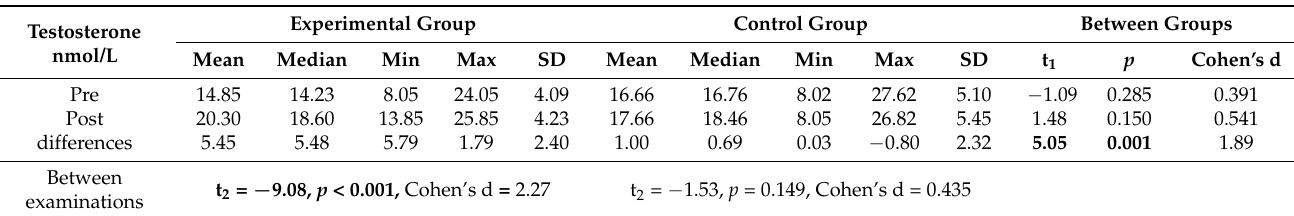
Between examinations